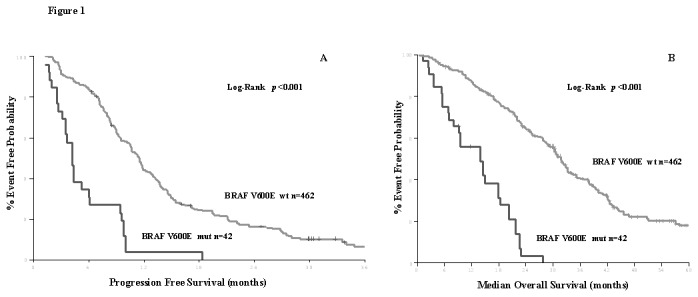
Progression Free Survival in 1st systemic treatment according to BRAFV600Emutation in 504 patients with metastatic Colorectal Cancer (A) and Median Overall Survival according to BRAFV600Emutation in 504 patients with metastatic Colorectal Cancer (B).